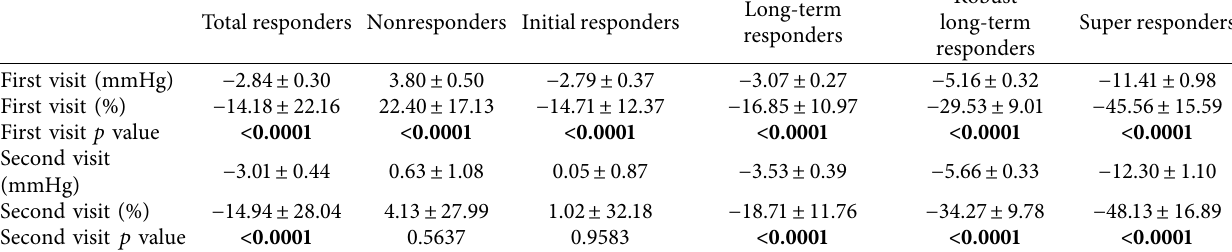
Table 4: IOP reduction at frst and second